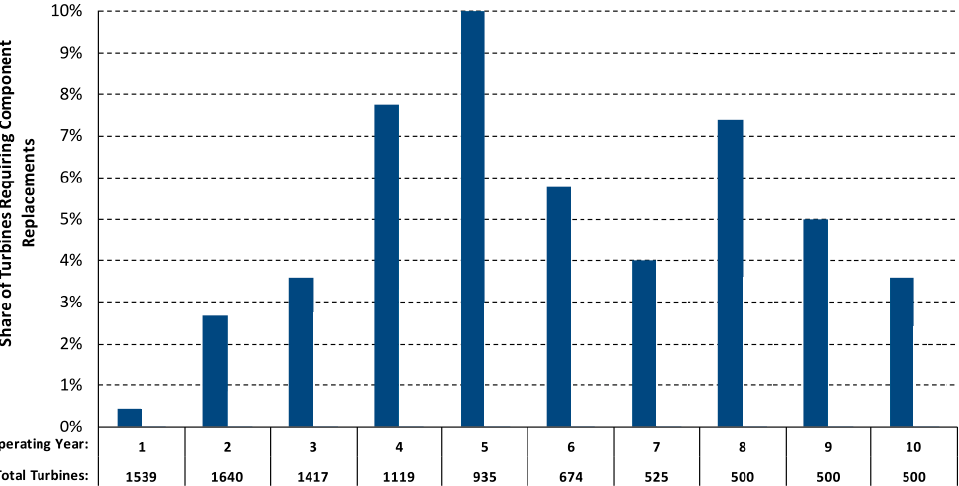
Figure 8. Average annual replacement rate of gearboxes [71].